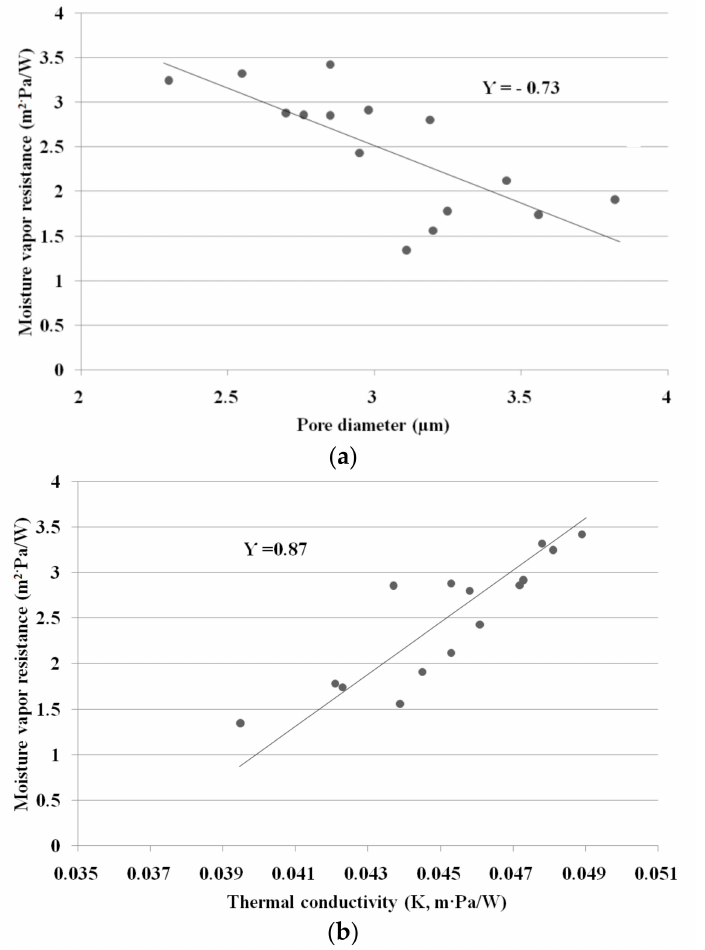
Figure 8. Correlation diagram between each wear comfort characteristic of the fabrics: ( a ) moisture vapor resistance and pore diameter; ( b ) moisture vapor resistance and thermal